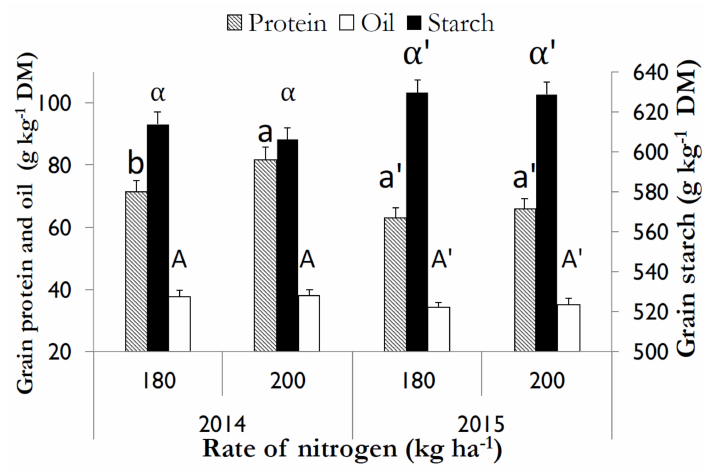
Figure 2. Effect of nitrogen rate on grain protein (striped bars), oil (white bars), and starch (black bars) concentrations during two growing seasons averaged for temperate and tropical maize grown in Boone County, IA. Treatments were determined within each year. Different letters on the top of standard error bars mean significant differences among treatments ( p > 0.05).